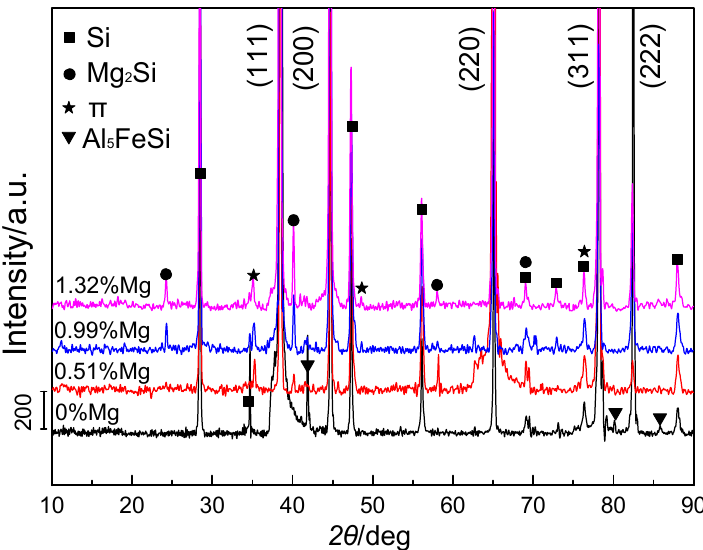
Figure 2. XRD patterns of Al-8Si alloy ingots without Mg and with 0.51%, 0.99%, and 1.32% Mg. The SEM images of Al-8Si alloy and Al-8Si-(0.33–1.32)Mg alloy ingots are shown in Figure 3, and the typical EDS analysis of each alloy phase obtained from one large-enough detection point in Figure 3 are summarized in Table 2.